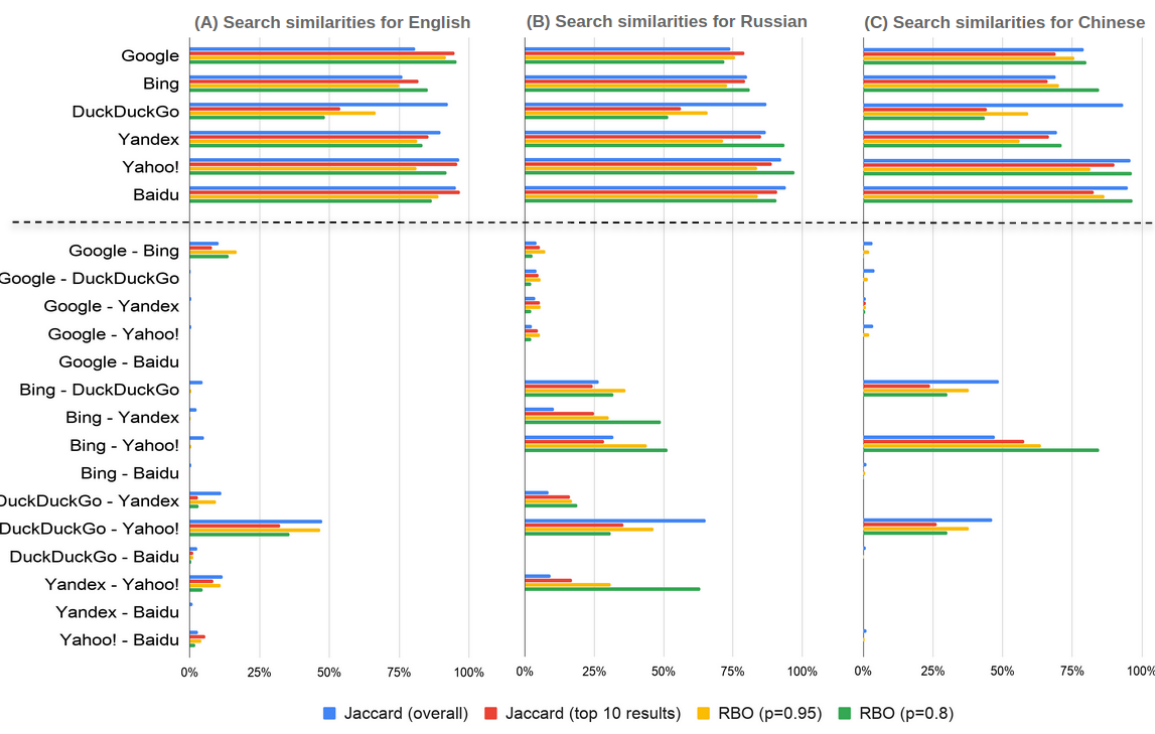
Figure 4. Average similarities (%) for paired agents according to search engines across languages. JI stands for the Jaccard index and RBO stands for the Ranked Biased Overlap. The x-axis shows the average percentage for each of the similarity metrics, and the y-axis shows the pairs of search engines that are